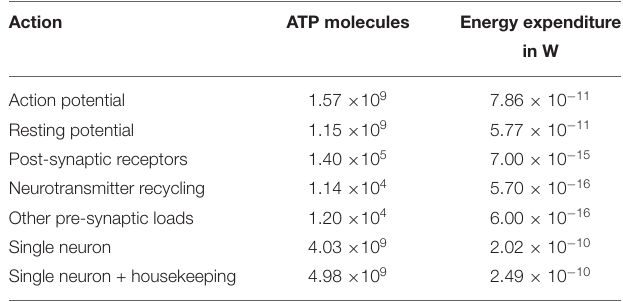
TABLE 1 | Various contributions to the overall energy expenditure of the human